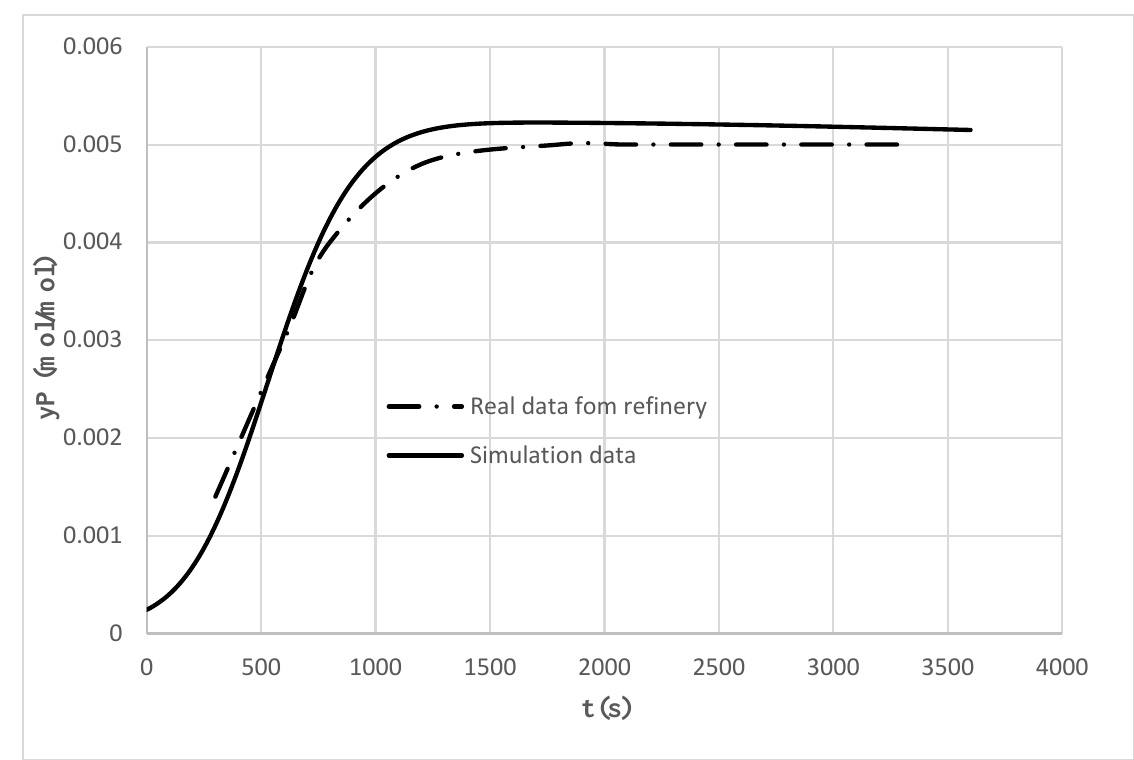
Figure 4. Comparison of simulation and industrial data for the pentane mole fraction in the output stream.